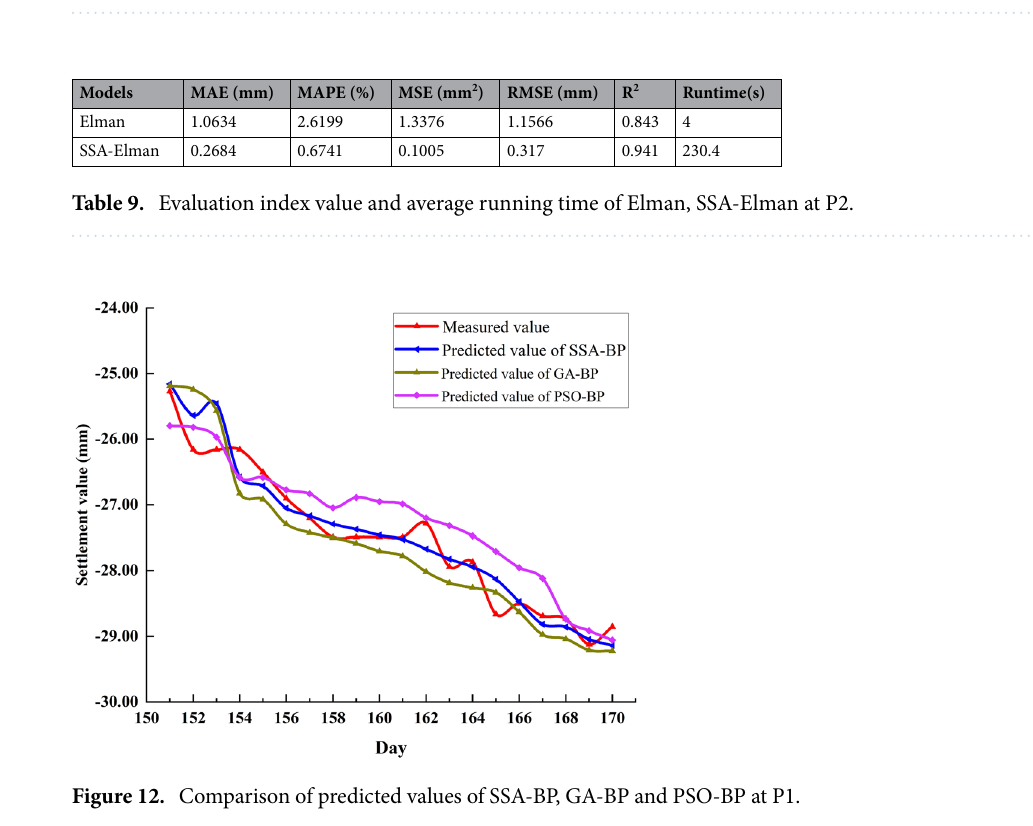
Table 8. Predicted value variance of Elman and SSA-Elman at P2.